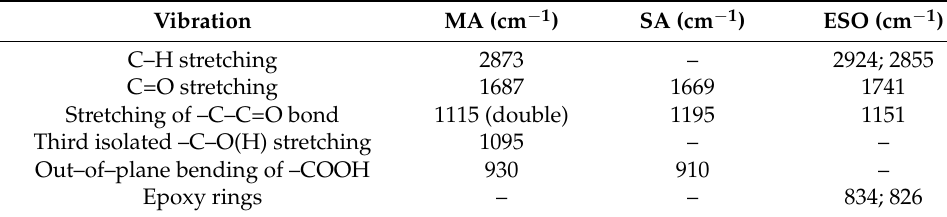
Figure 2. ( a ) infrared spectra of succinic acid (SA), malic acid (MA) and epoxidized soybean oil (ESO); ( b ) spectra of ESO and MA mixture recorded after thermal treatment at 60 ◦ C and 190 ◦ C; ( c ) spectra of ESO and SA mixture recorded after thermal treatment at 60 ◦ C and 190 ◦ C. Table 3. Wavenumbers related to the main infrared ATR peaks of MA, SA, and